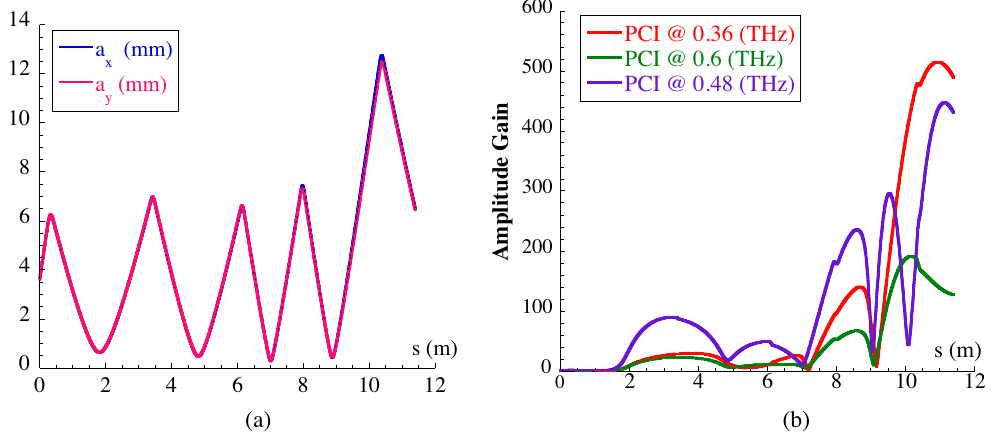
FIG. 14. (a) Simulated evolution of the horizontal and vertical beam envelopes and (b) PCI amplitude gain for modulation frequencies of 0.36 THz (red line), 0.48 THz (violet), and 0.6 THz (green). Simulations were done with code SPACE for 1.7 MeV ( γ ¼ 3 . 45 ), 0.7 nC, 0.4 nsec electron bunch with 1 μ m normalized slice emittance and 0.01% slice rms energy